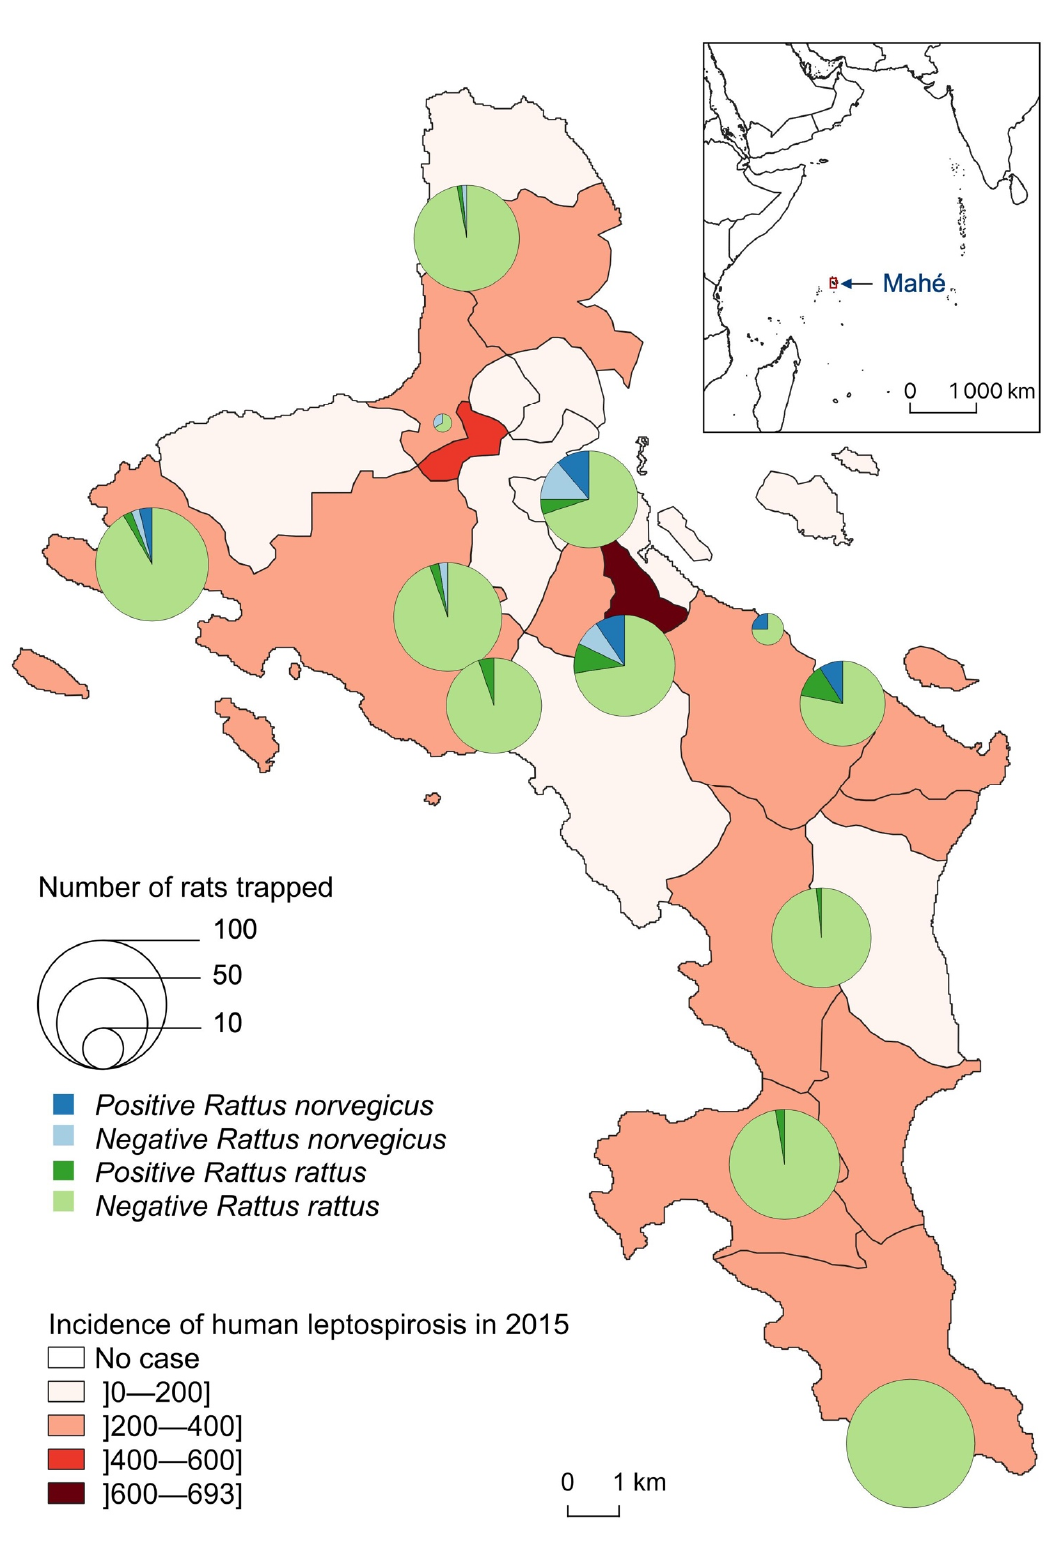
Figure 3. Number of Leptospira -infected (positive) and noninfected (negative) Rattus trapped, by species and site, compared to the incidence of human leptospirosis by district in 2015 (for 100,000